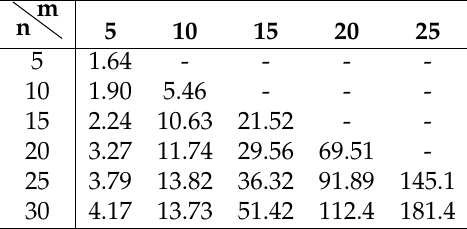
Table A7. Least-squares solution time using Legendre polynomials in milliseconds for Problem